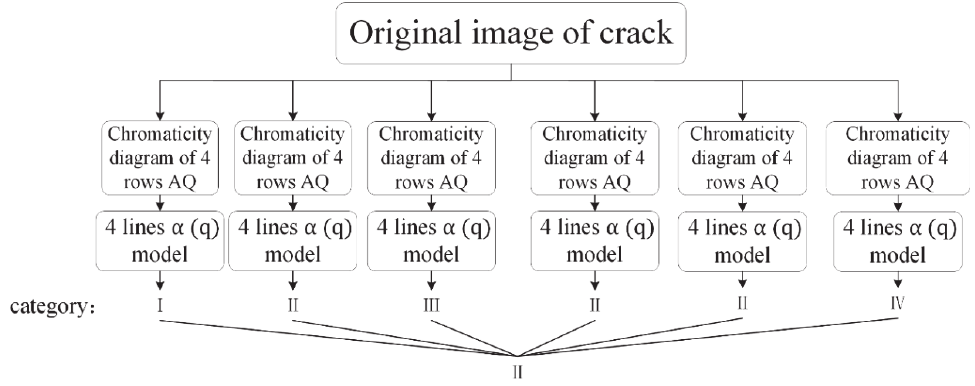
Figure 10. Each model obtains a recognition result, and the model with the highest votes reveals the final category.